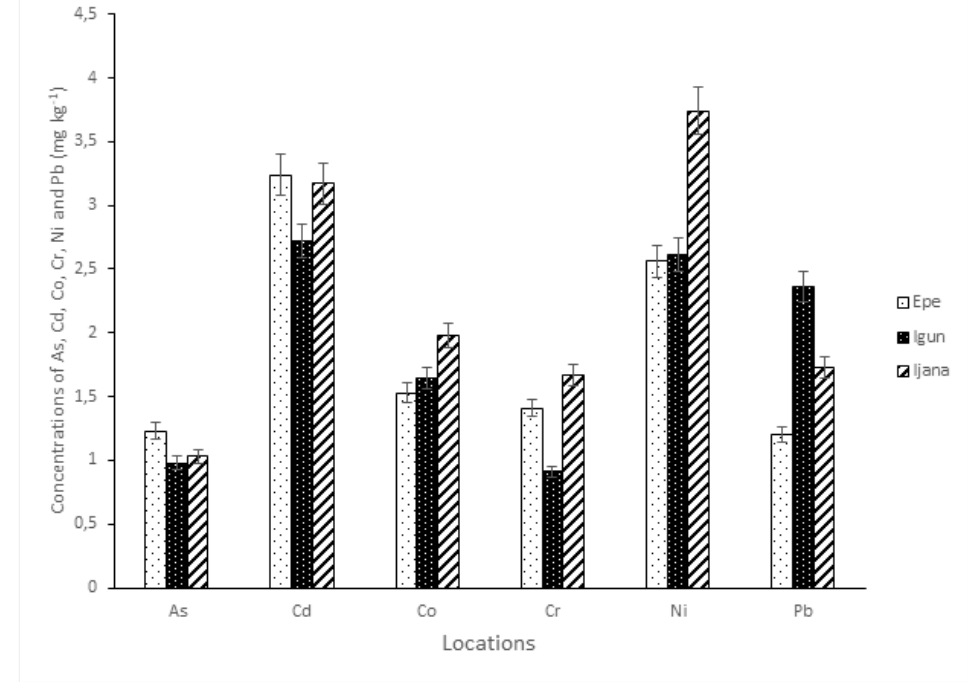
Figure 1: Concentrations of heavy metals (As, Cd, Co, Cr, Ni & Pb) in maize at Epe, Igun and Ijana